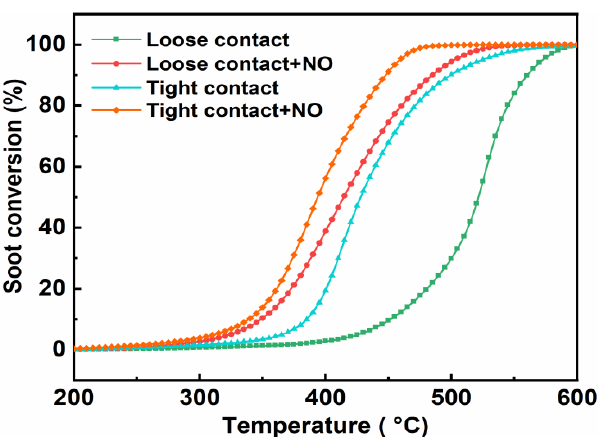
Figure 9. Soot conversion over the CuCo 2 O 4 -N catalyst under the loose and tight contact modes.